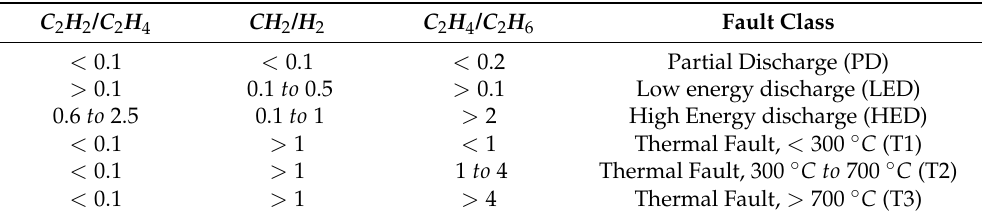
Table 3. IEC 60599:2022 standard fault